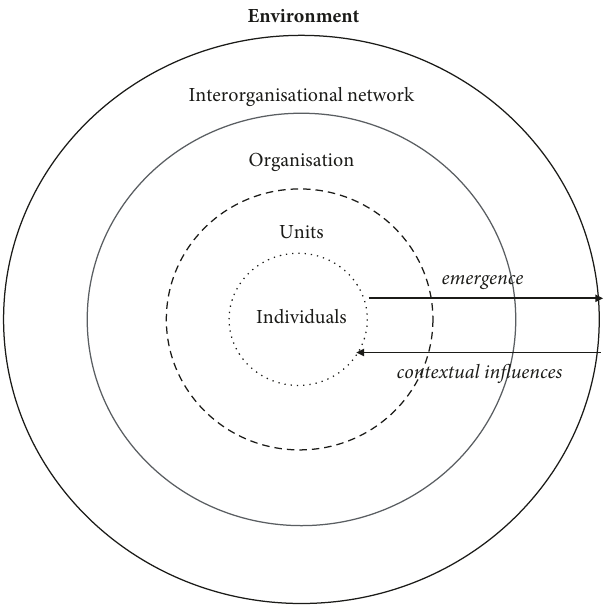
Figure 1: Nested character of complex organisational